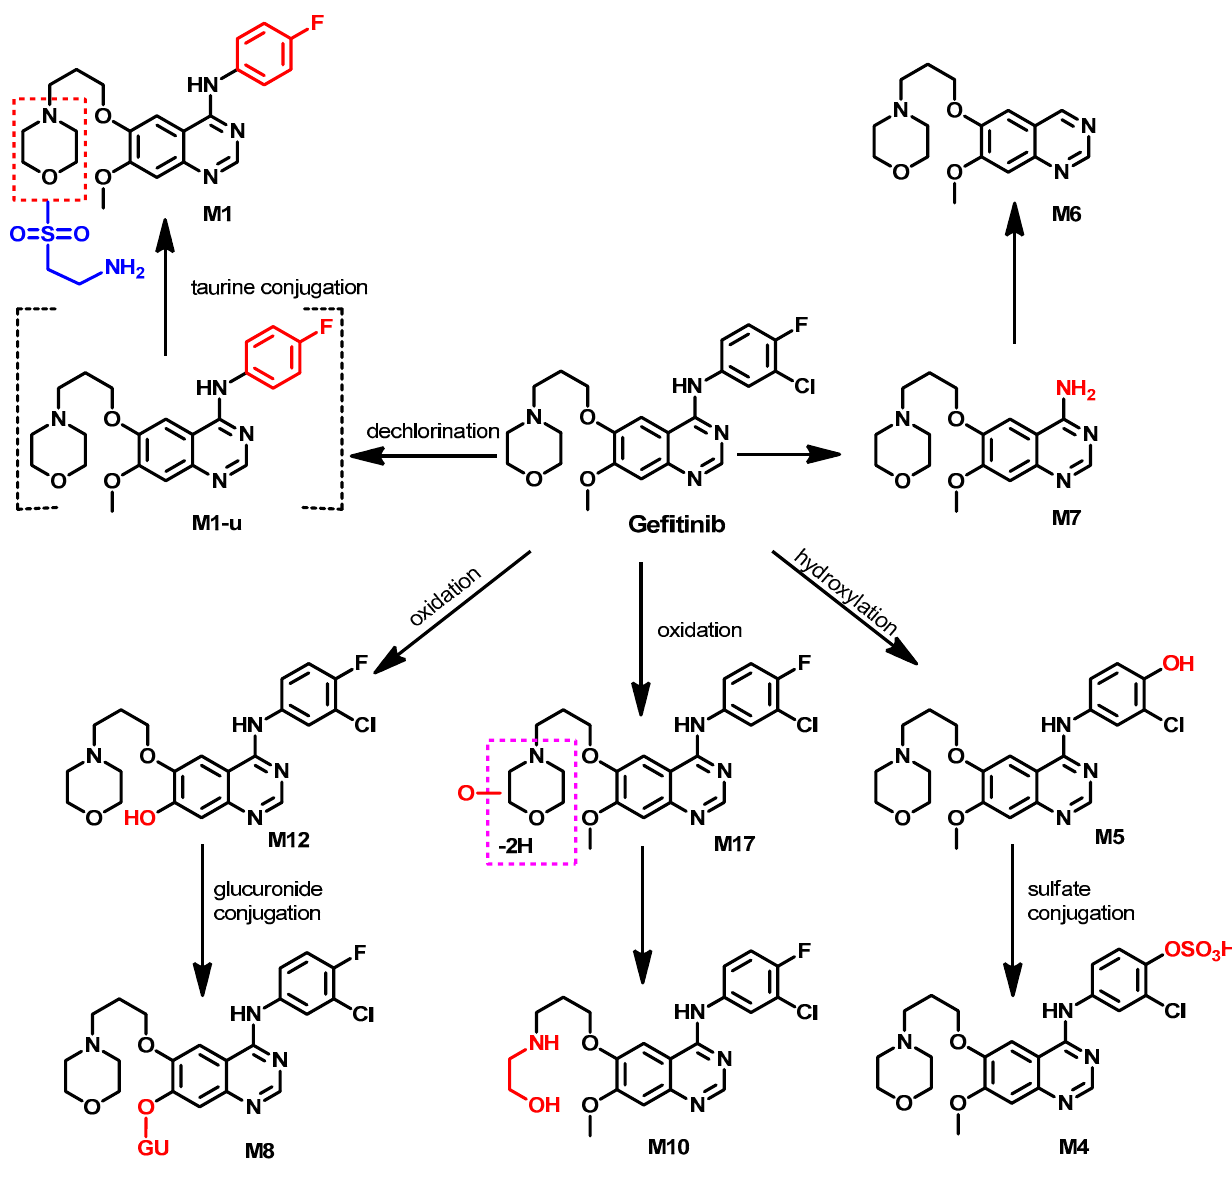
Figure 35. Proposed metabolic pathways of gefitinib.